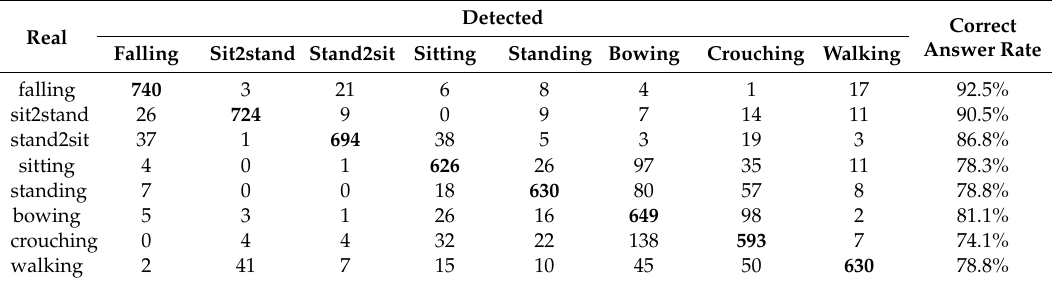
Table 3. Result of motion detection with the LSTM network.